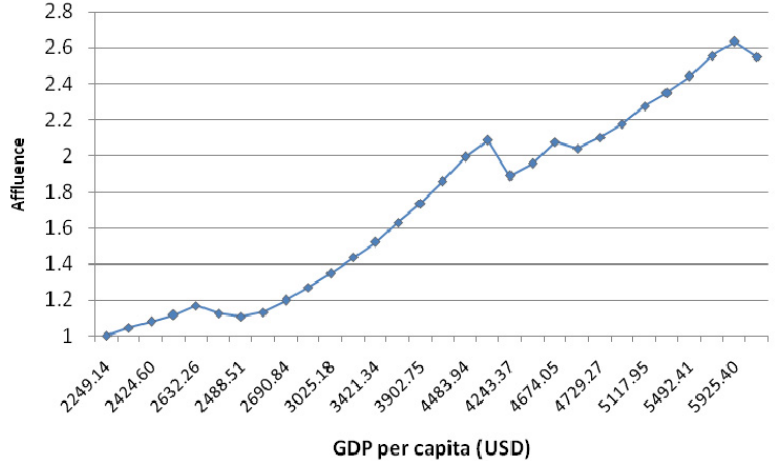
Figure 8. Relationship between affluence and GDP per